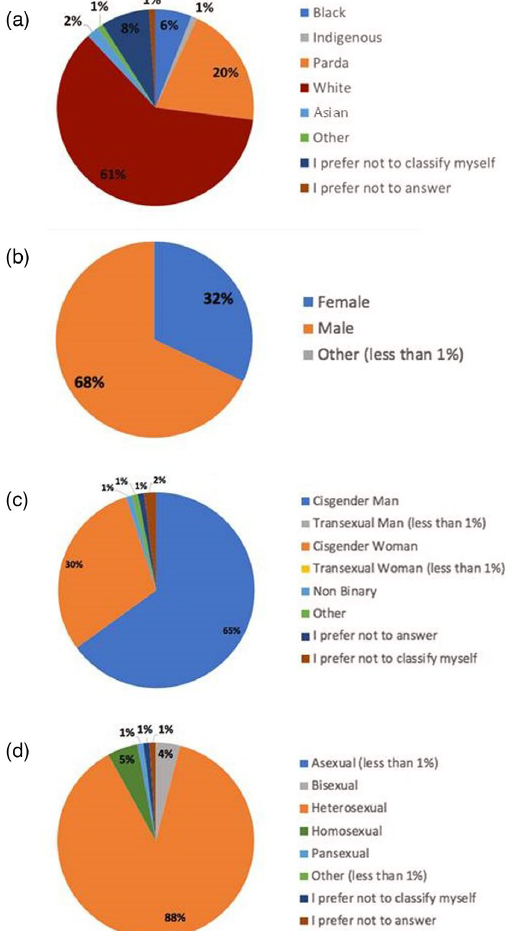
FIG. 2. Profile of the respondents according to ethnicity or race (a), sex (b), gender (c), and sexual orientation